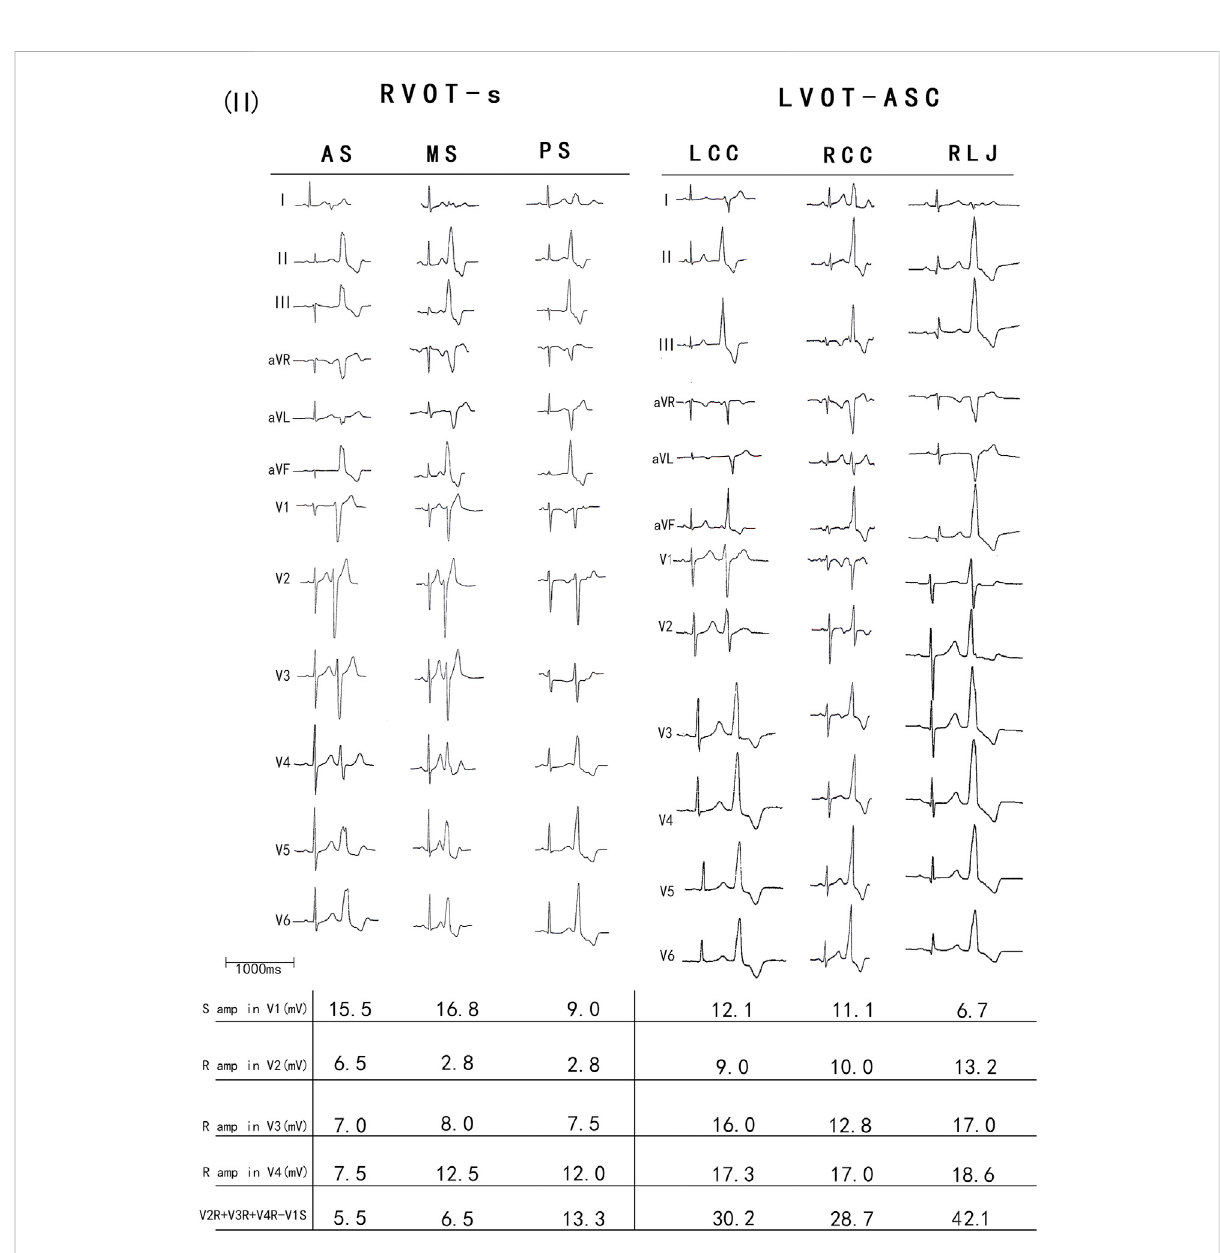
FIGURE 6 The representative images of surface ECGs and the R-S difference indexof both